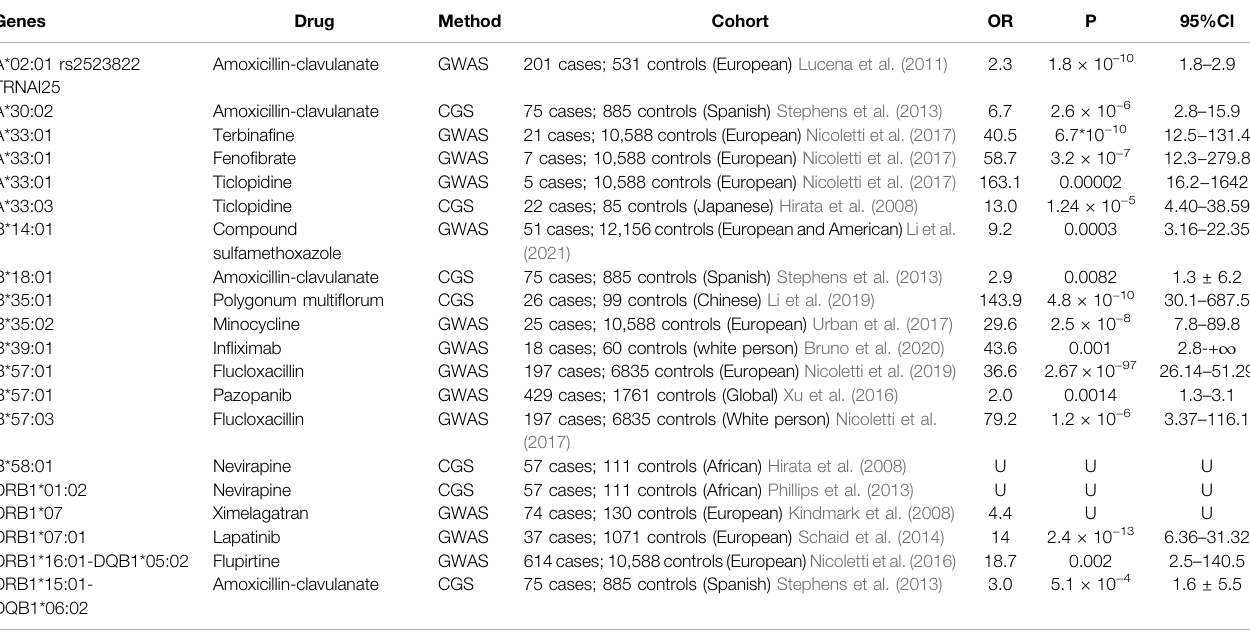
TABLE 1 | Polymorphisms of DILI-related HLA genes identi fi ed in GWAS and CGS.